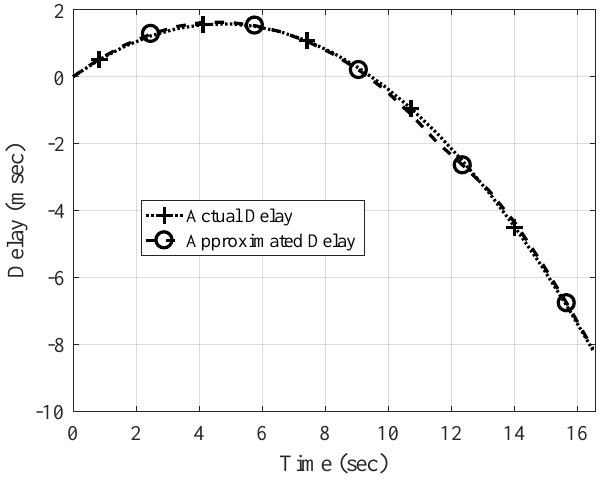
Figure 7. An example of time-varying delay estimation. The delay of the strongest path changes with time following a quadratic